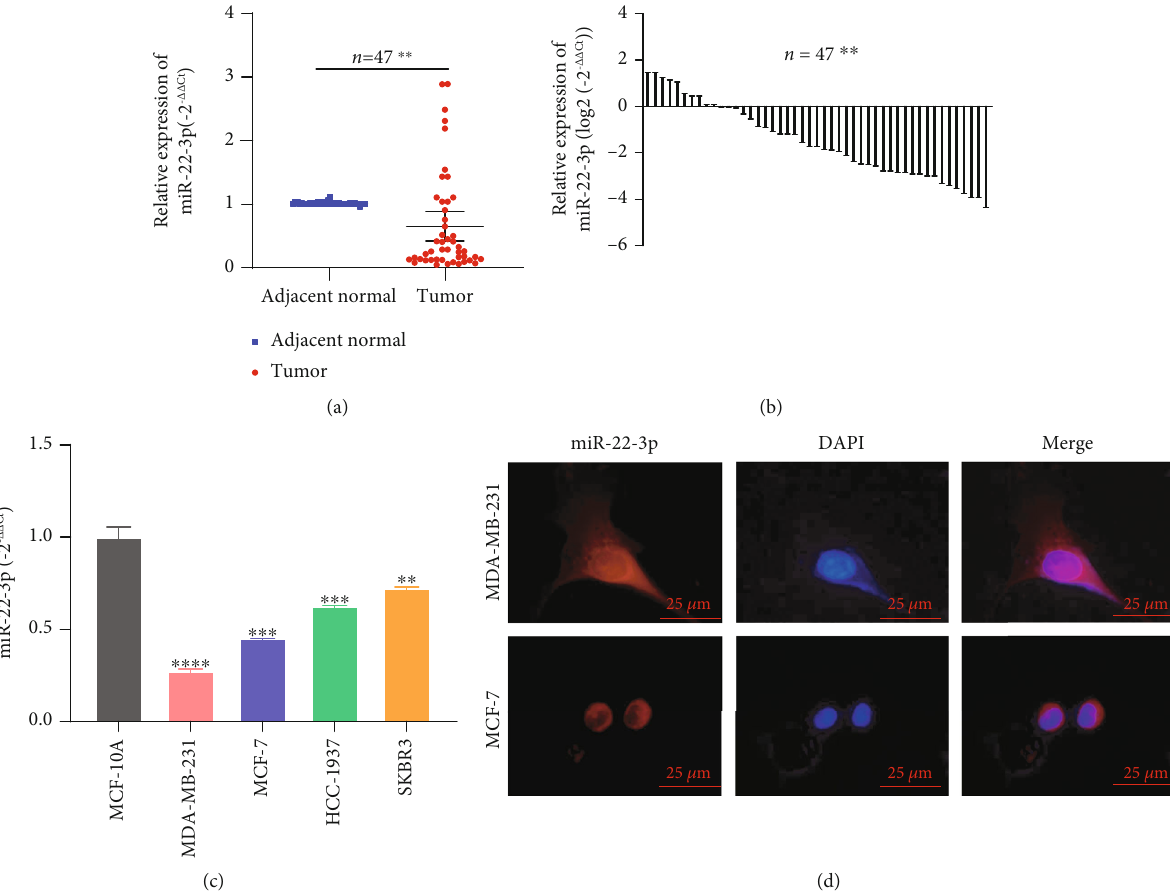
Figure 1: miR-22-3p was decreased in BC cell lines and tissues. (a, b) miR-22-3p had low expression in BC tissues compared with adjacent normal tissues. (c) miR-22-3p had low expression in BC cell lines. (d) Detection of colocalization of miR-22-3p in cytoplasm by RNA FISH assay (magni fi cation, × 400). Red, miR-200a-3p; blue, DAPI. ∗∗ p < 0 : 1 ; ∗∗∗ p < 0 : 001 ; ∗∗∗∗ p < 0 : 0001